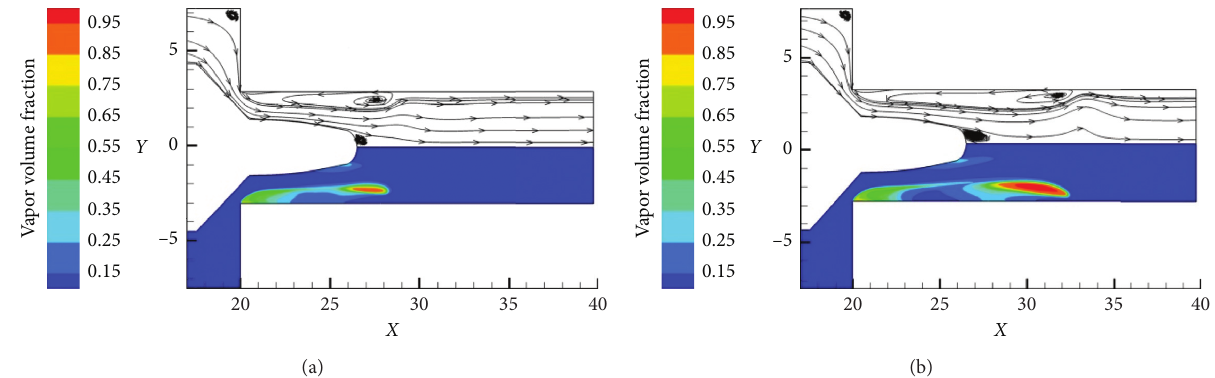
Figure 4: Flow charts (the upper part) and the distribution of vapour volume (the down part) at (a) t